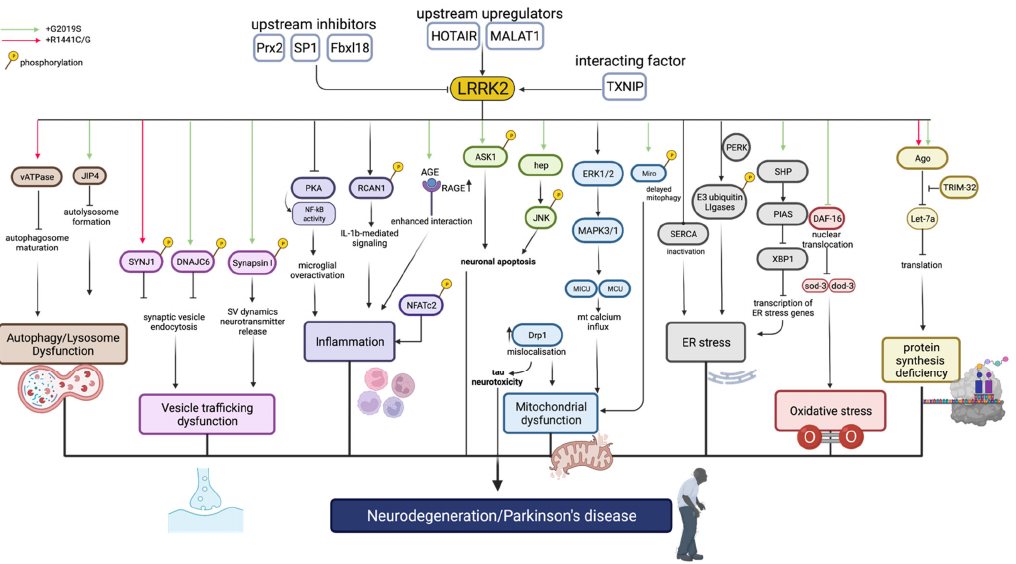
Figure 3. Targets of LRRK2 and associated mechanisms. Upstream and interacting factors of LRRK2 include Prx2, SP1, Fbxl18, HOTAIR, MALAT1, and TXNIP. Downstream factors related to autophagy and lysosomal dysfunction, vesicle trafficking, inflammation, mitochondrial dysfunction, ER stress, oxidative stress, and protein synthesis deficiency are shown. Green arrows represent targets associated with G2019S mutation, whereas red arrows are associated with R1441C/G mutations. Created with BioRender.com (accessed on 25 July 2022).